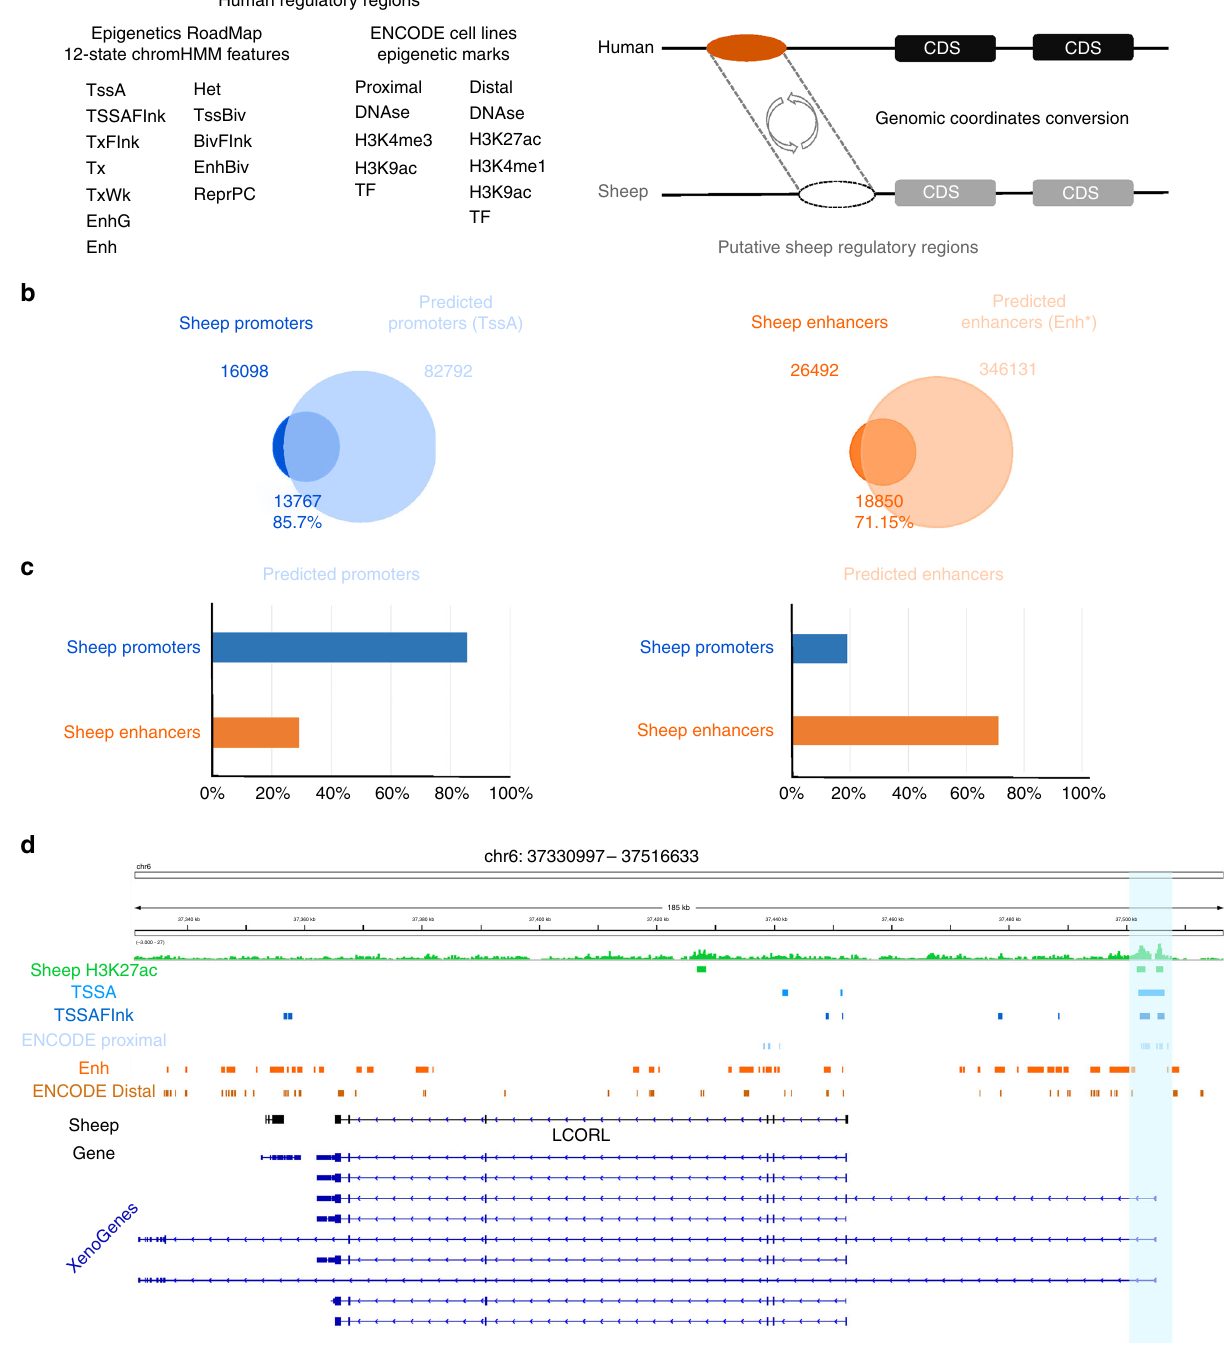
Fig. 3 Prediction and validation of sheep gene regulatory elements. a Human Epigenome Roadmap chromatin states and ENCODE features used in a reciprocal liftOver protocol to predict regulatory regions in sheep. b Overlap between chromosomal locations identi fi ed by experimental sheep tissue ChIP- Seq (H3K4me3 and H3K27ac) and regions predicted by liftOver. H3K4me3 peaks are compared against predicted Roadmap chromatin state TssA identifying active promoters (left) and unique H3K27ac peaks are compared to the Roadmap Enh state, excluding those regions overlapping with predicted TssAs, identifying distal enhancers (right). c The proportion of predicted promoters (left) and enhancers (right) recovered by ChIP-Seq using either H3K4me3 peaks (blue bar) or unique H3K27ac peaks (orange bar). This demonstrates the predicted annotations retain a level of speci fi city between components of the gene regulatory apparatus. d An example annotated region containing LCORL highlights the correspondence between ChIP-Seq data (Sheep H3K27ac) and liftOver predictions (TSSA, TSSAFlnk, ENCODE proximal, Enh, ENCODE